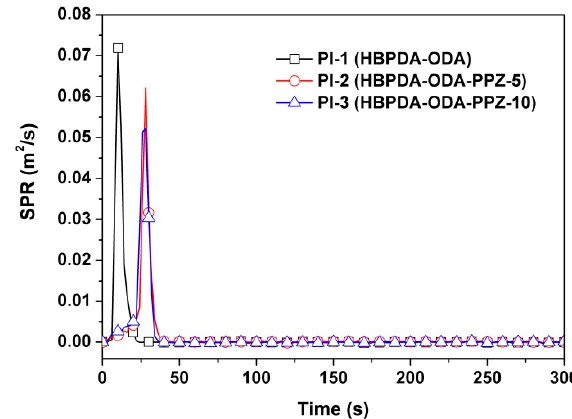
Figure 13. SPR plots of PI films.